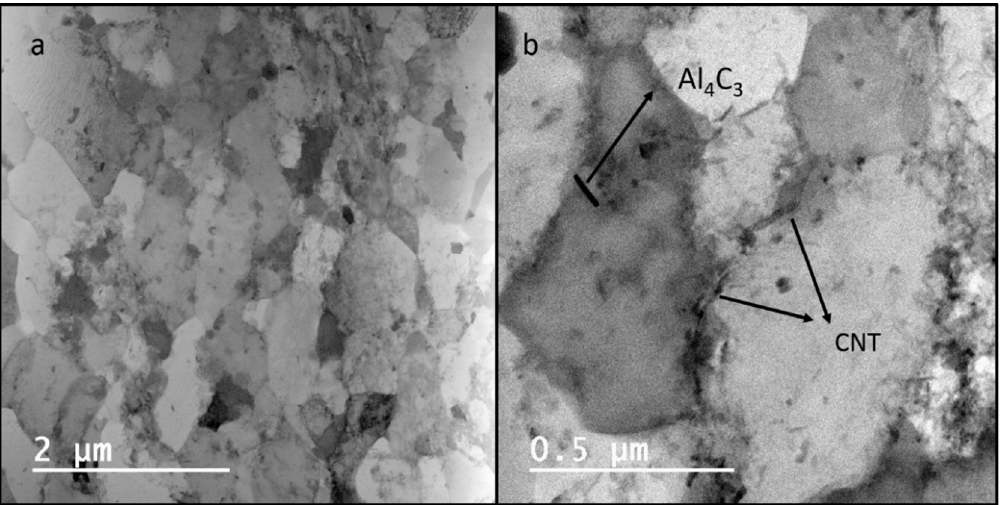
Figure 14. XRD pattern of extruded 7075-1 wt.% MWCNT.